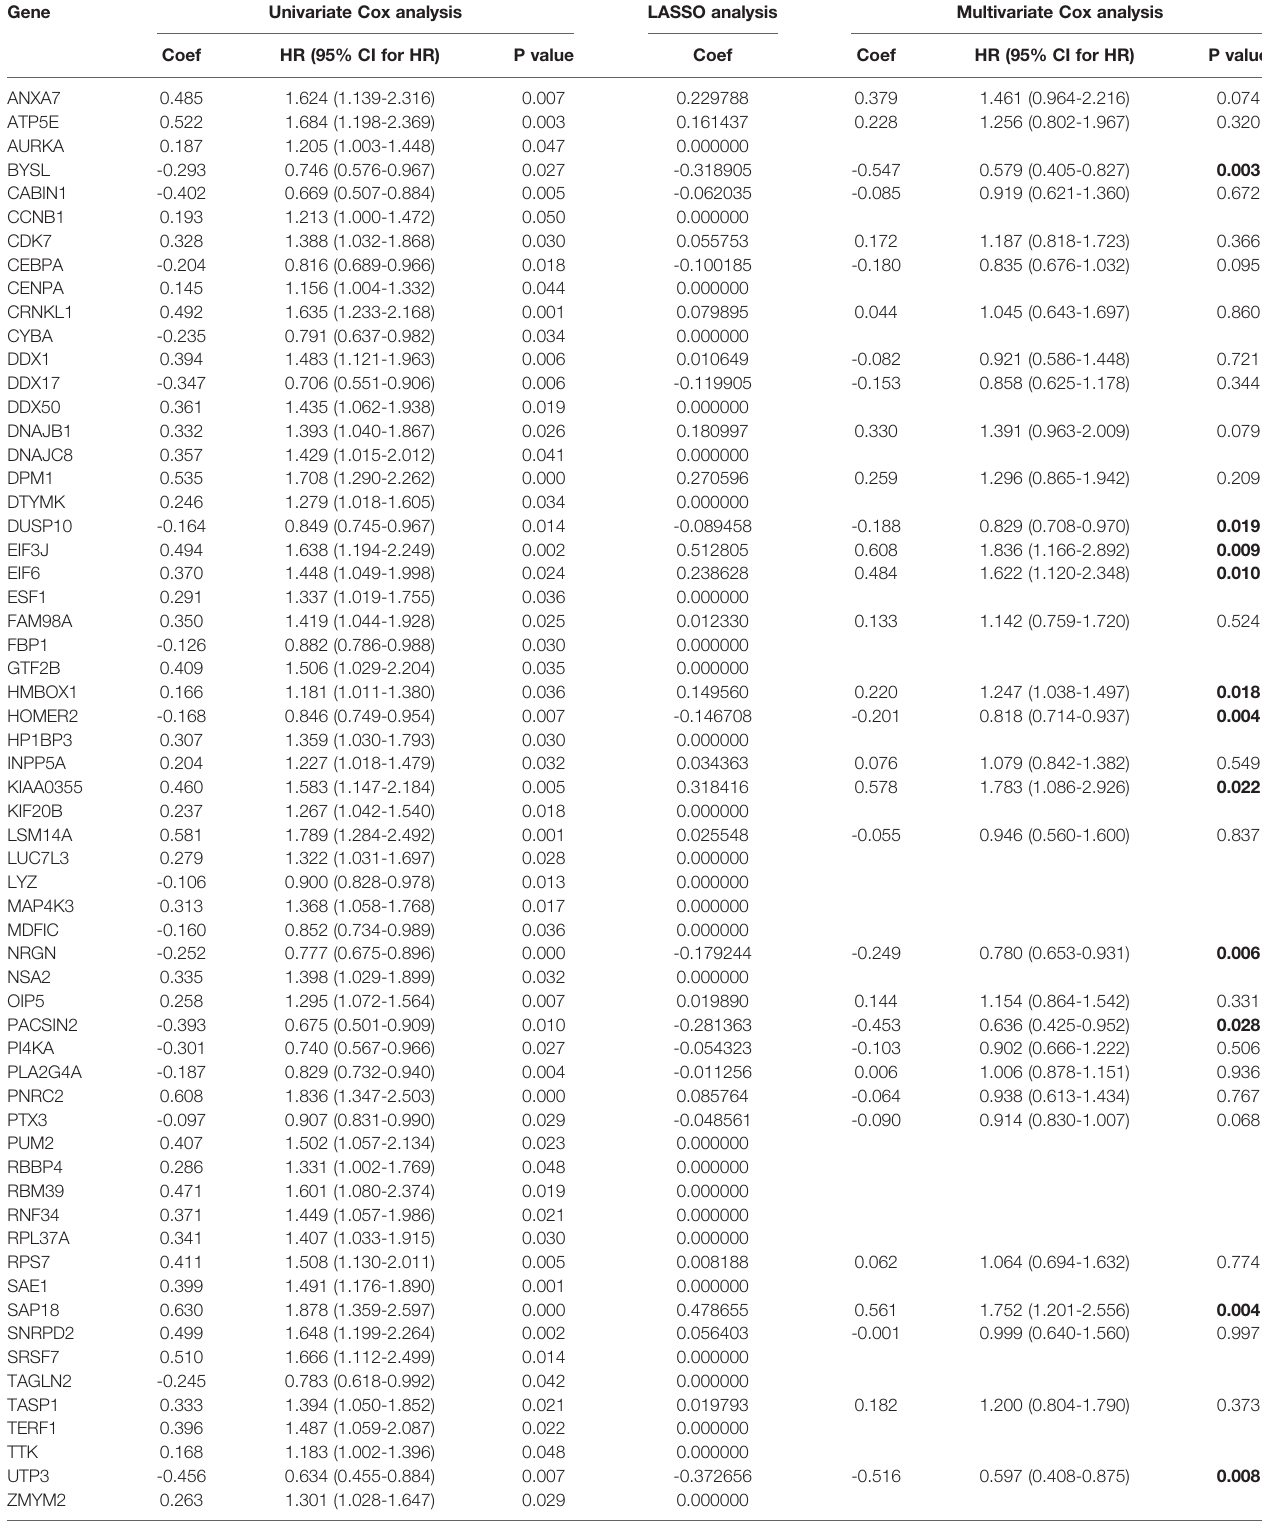
TABLE 1 | The overall survival-related genes and their coef fi cients.